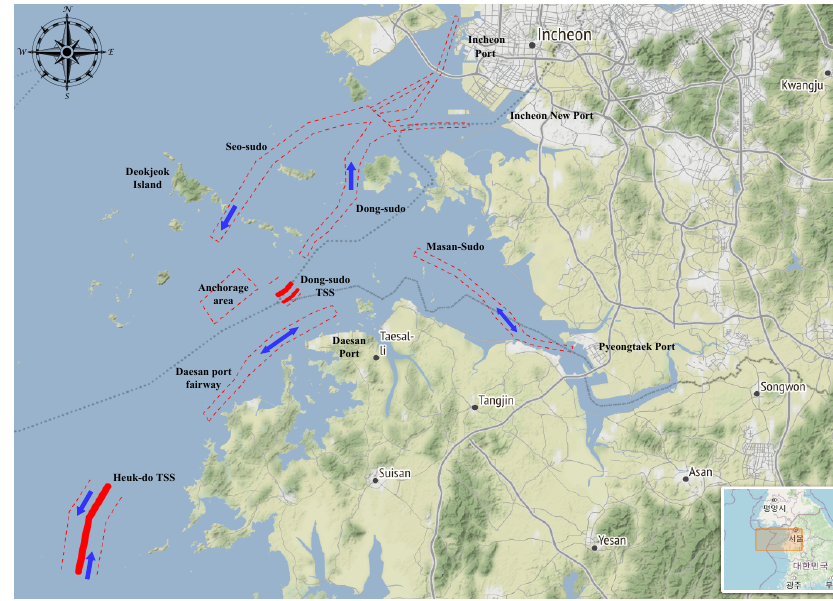
Figure 5. Overview of the Incheon port approach area.